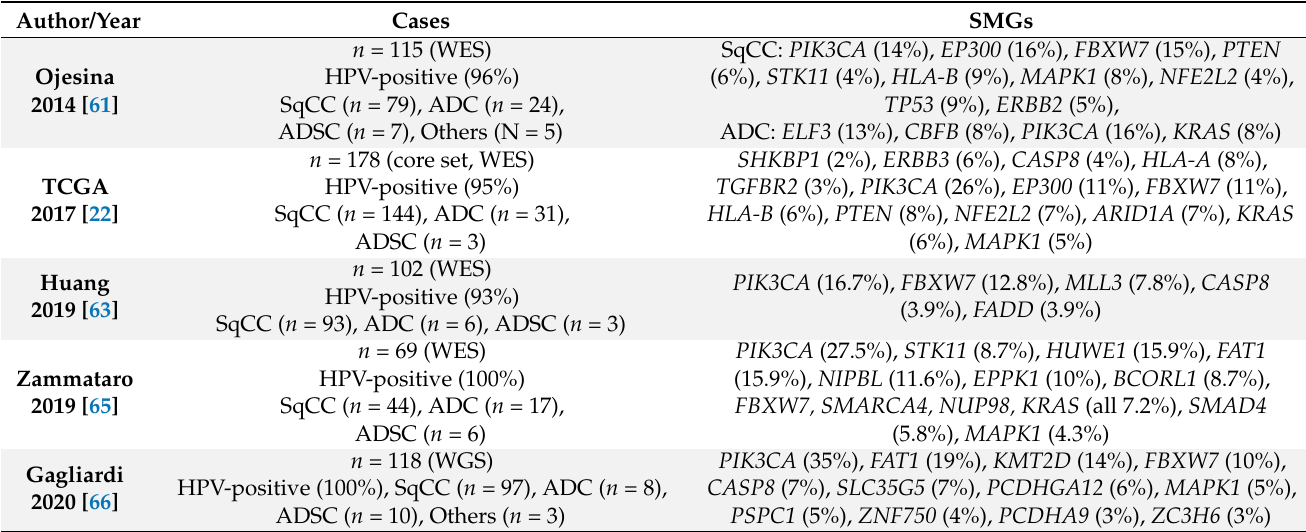
Table 4. Significantly mutated genes (SMGs) in whole exome/whole genome sequencing of cervical